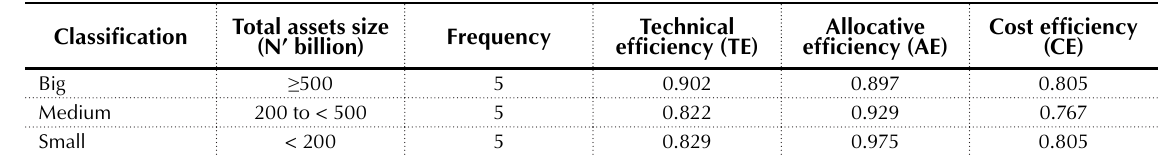
Source: authors’ computation.